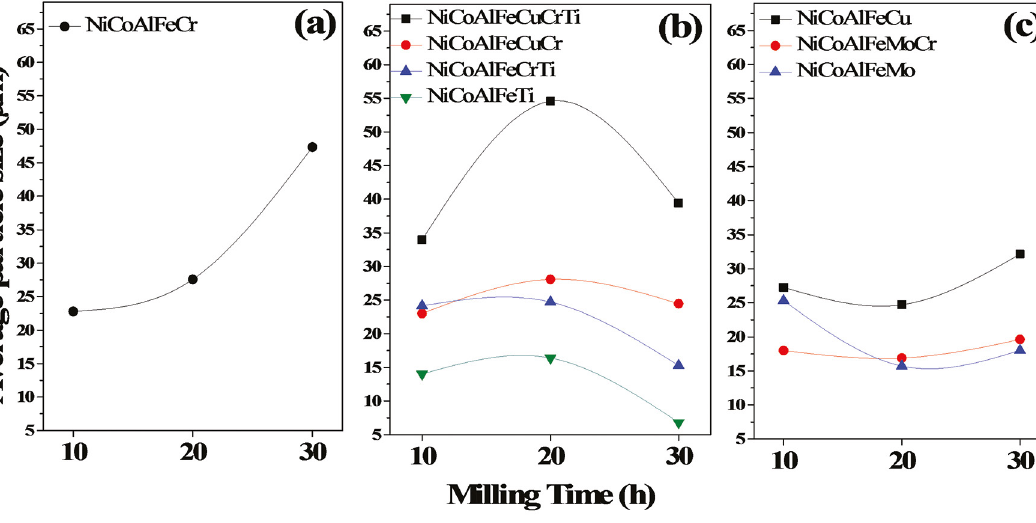
Figure 3: Average particle size of as-milled powders as a function of the milling